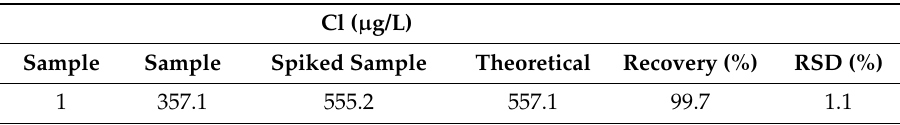
Table 4. The results of determination of chlorine in sample no 1 spiked with chloride (200 µ g/L). Matrix (PGL no 1) concentration ~0.1%, n = 4.